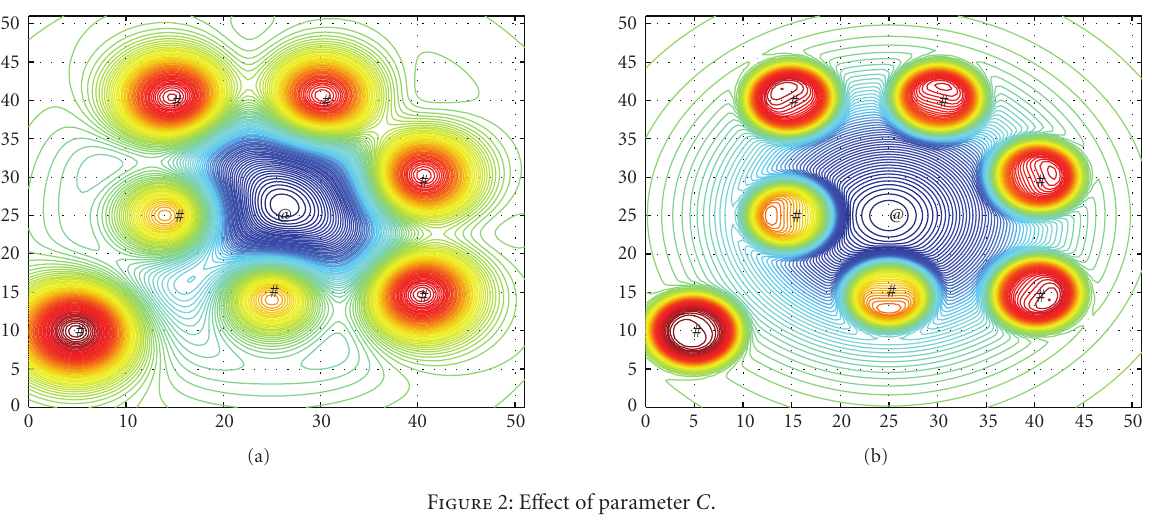
Figure 2: E ff ect of parameter C